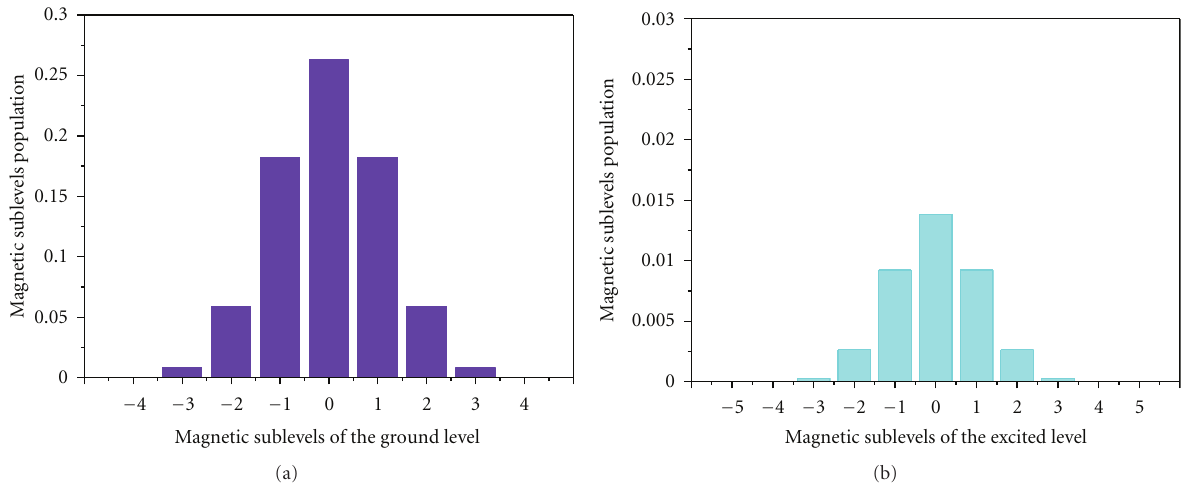
Figure 6: Illustration of the population distribution between the Zeeman sublevels of the ground level F g = 4 (a) and of the excited level F e = 5 (b) for the F g = 4 → F e = 5 transition, without depolarization factors influencing the excited level. The ground-level population is mainly accumulated on the sublevels m F = 0, ± 1, having the highest excitation probabilities (Clebsch-Gordon coe ffi cients).